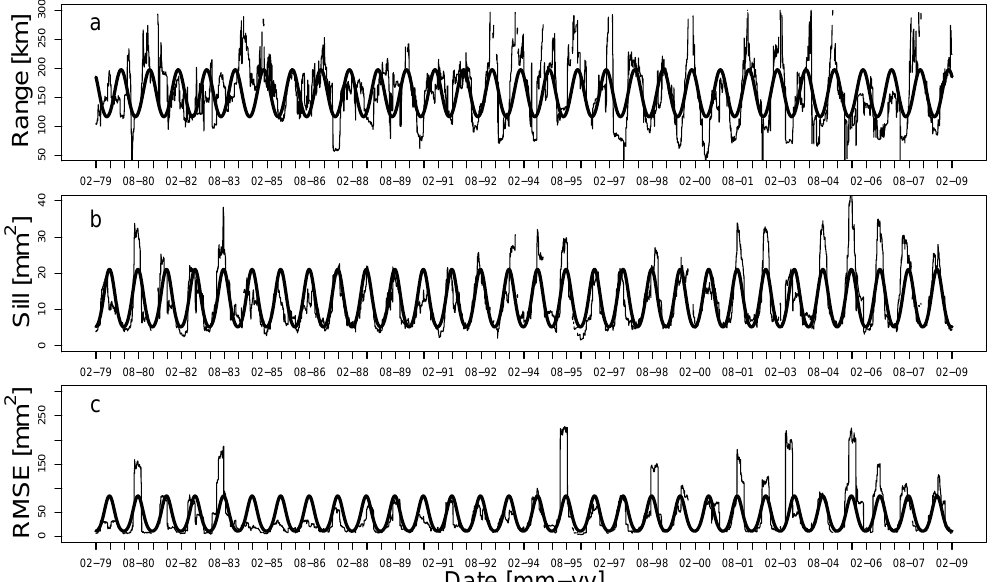
Fig. 5. Variation of 90-day moving window variogram parameters range (a) , sill (b) and root mean squared error (c) for 30 years of daily rainfall data. The thin lines are the values found for each daily average and the bold lines are the cosines fitted through the data.